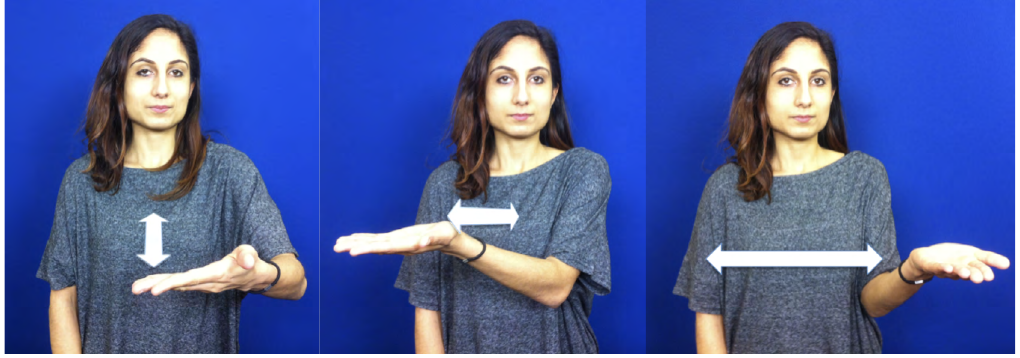
Figure 8. Three types of direction coded for indicating verbs with BSL give Two further categories were also employed for direction: ‘other’ and ‘ambiguous’. The category of ‘other’ refers to verbs that moved in a direction not corresponding to those presented in Figure 8. These tended